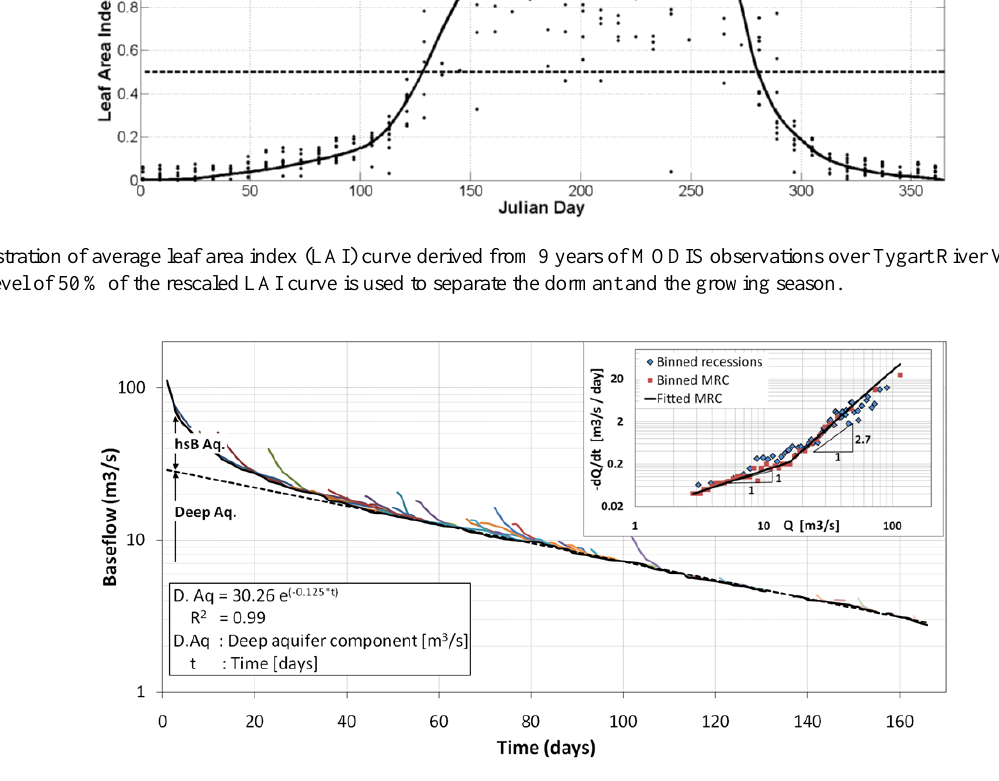
Fig. 2. Illustration of derivation of the master recession curve (MRC) for San Marcos, TX catchment and the separation of recession flow derived from the perched and the bedrock aquifer. The inset shows a Brutsaert-Nieber plot of recession rates versus baseflow. The lower end reveals the linear reservoir response of the deep aquifer whereas the upper end shows the non-linear recession characteristics against which the hillslope-storage Boussinesq equation is calibrated.